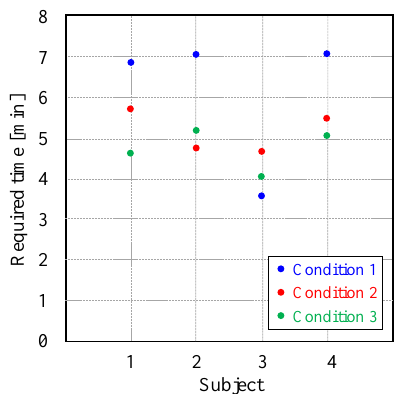
Figure 14. Required time for each subject and condition.